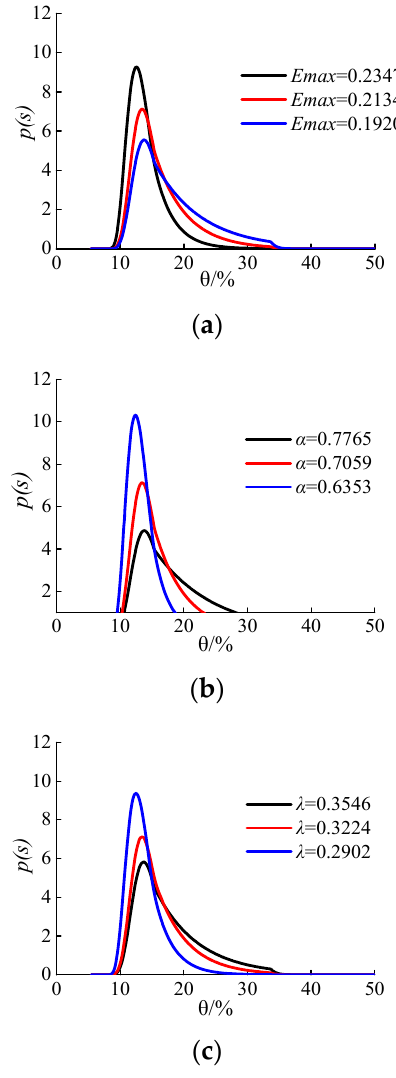
Figure 14. Influence of the strongly ‐ sensitive parameters on the Laio model results. ( a ) Influence of E max on model results; ( b ) Influence of α on model results; ( c ) Influence of λ on model results.